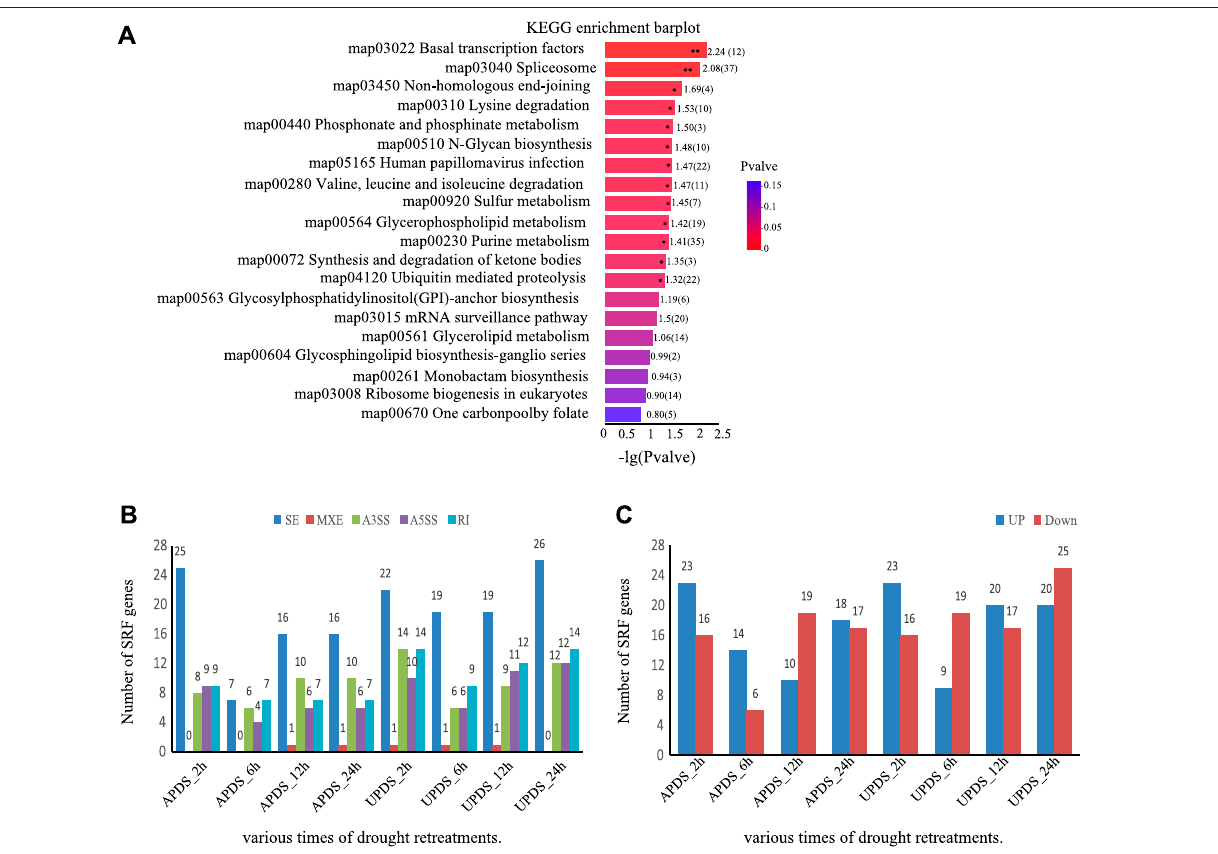
FIGURE 6 | Expression and AS analysis of SPF-related genes in different drought treatments. (A) Top 20 pathways enriched with DSGs. − Log10 ( p -value) expresses the ratio of the number of DSGs to the number of genes annotated in the pathway. The larger the − Log10 ( p -value), the greater the enrichment. **, p < 0.01; *, p < 0.05. (B) Number of signi fi cantly differentially spliced SPF-associated genes at different time points under drought stress. (C) Number of signi fi cantly differentially expressed SPF-associated genes at different times points under drought